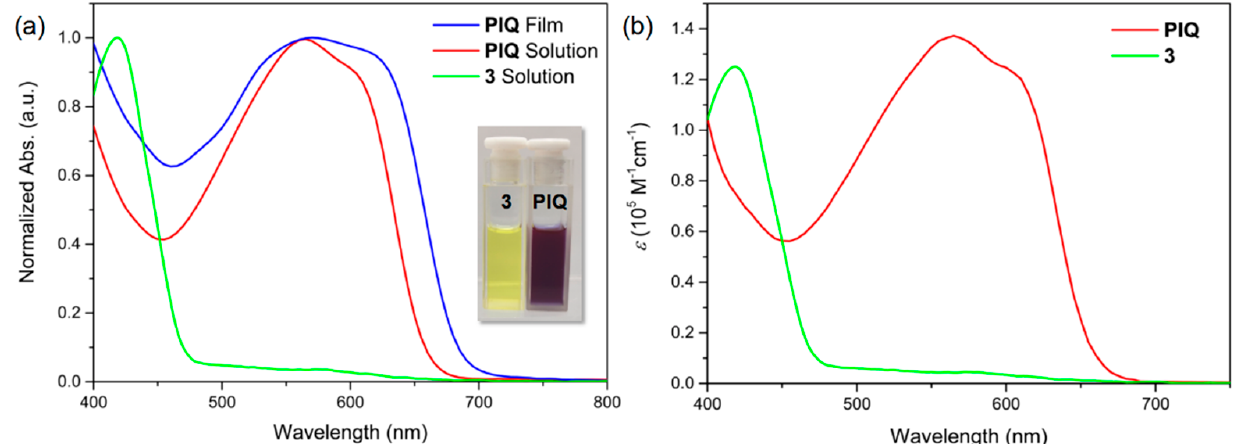
Figure 2. ( a ) Normalized UV-vis absorption spectra of monomer 3 and polymer PIQ in chlorobenzene solutions and PIQ as thin film (insert, photograph); ( b ) UV-vis absorption spectra of monomer 3 and PIQ in chlorobenzene solutions. Table 1. The optical and electrochemical properties of PIQ .